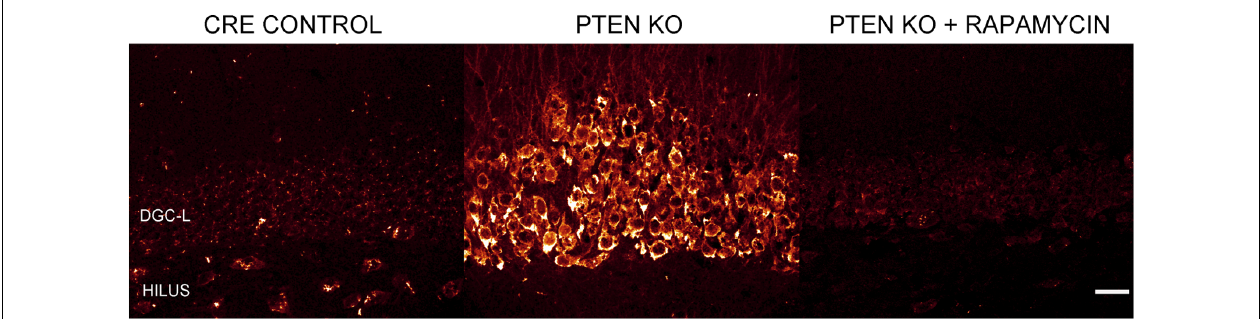
complex 1, is greatly increased in the dentate granule cell layer (DGC-L) in the PTEN KO animal, demonstrating the upregulation of mTOR signaling with the removal of PTEN. Rapamycin treatment, and thus inhibition of mTOR, prevents the increase in pS6 in PTEN KO mice. Scale bar = 25 μ m. Images courtesy of Isaiah